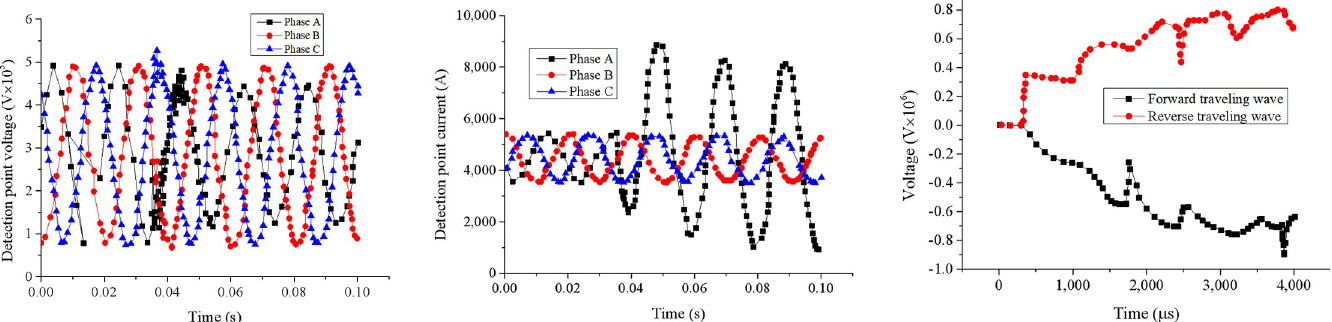
Fig 11. The fault traveling waves’ simulation results in a power relay system based on edge computing: (a) voltage at detection point; (b) current at detection point; (c) forward and reverse traveling waves.